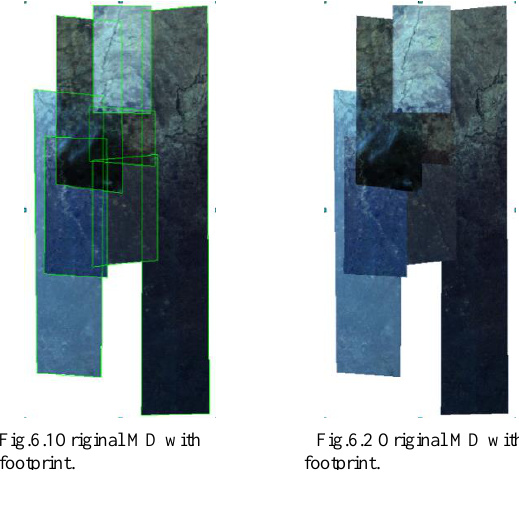
Fig.6.1Original MD with Fig.6.2 Original MD without